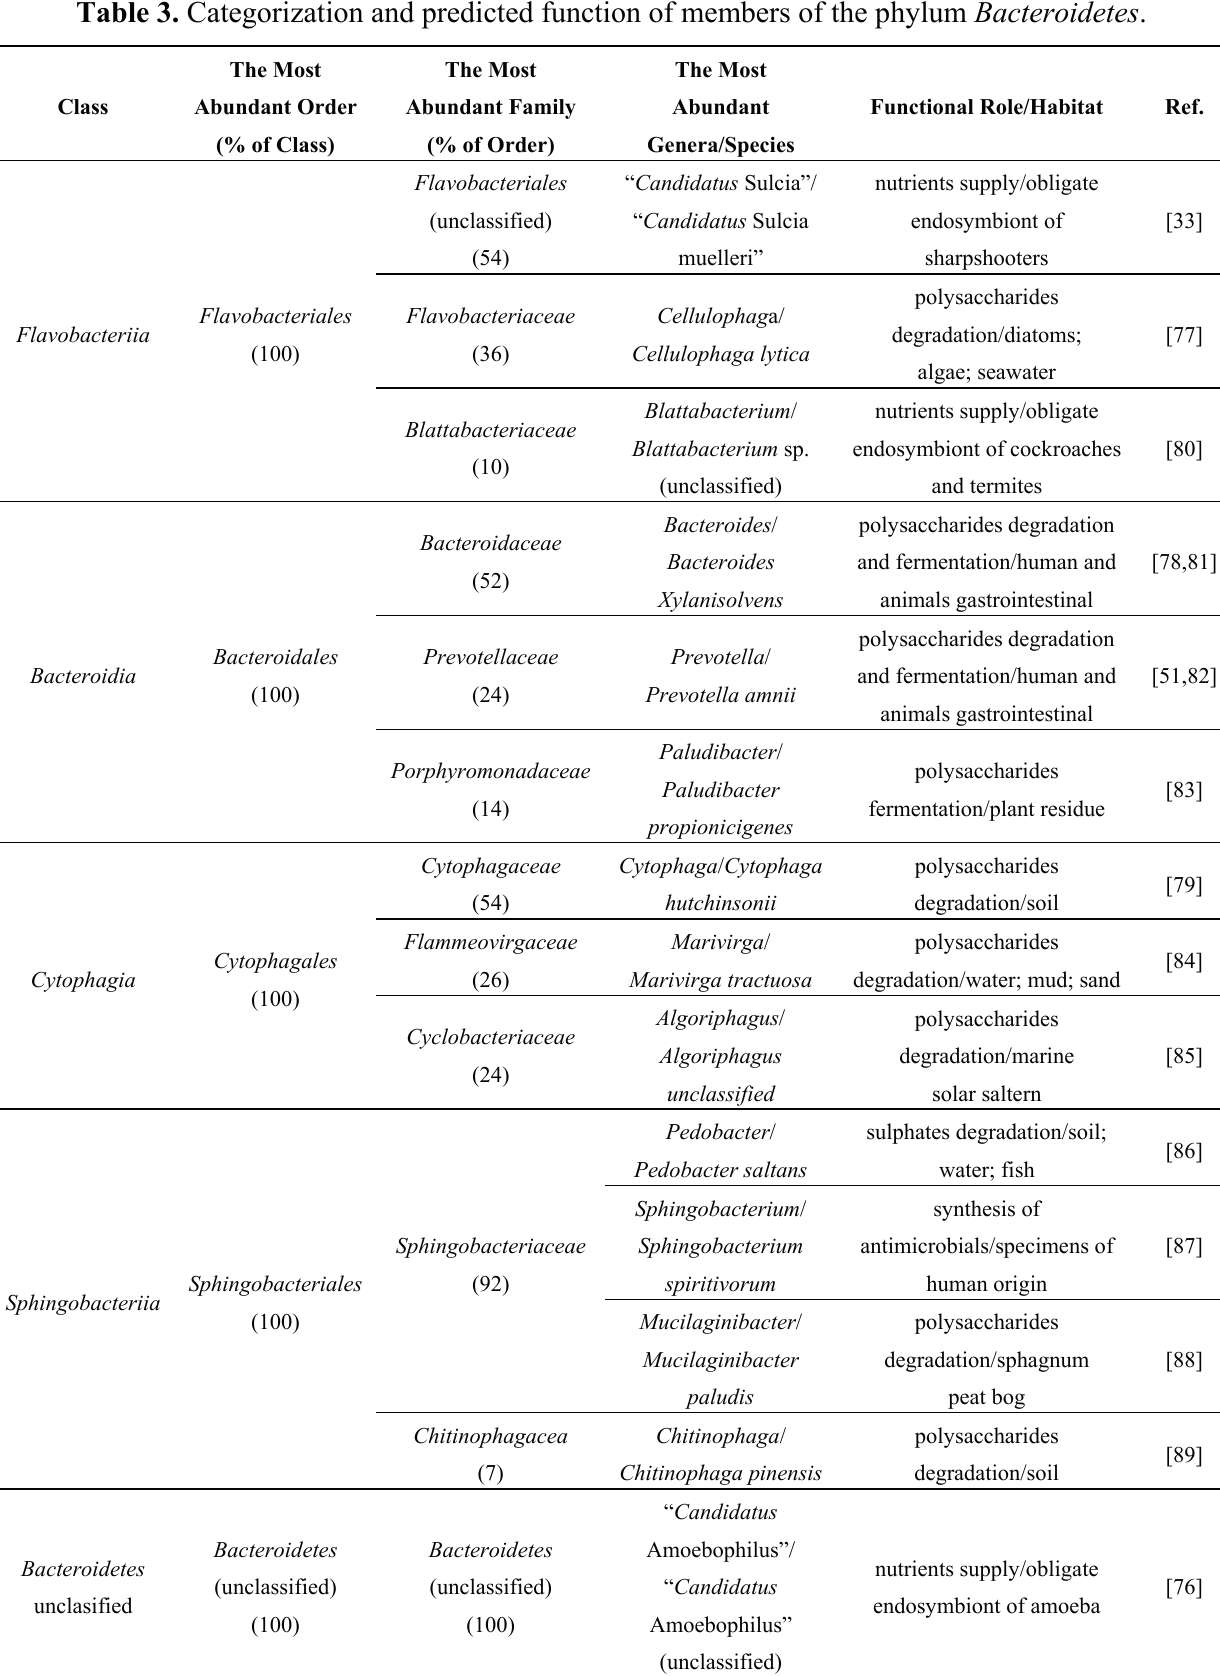
Table 3. Categorization and predicted function of members of the phylum Bacteroidetes